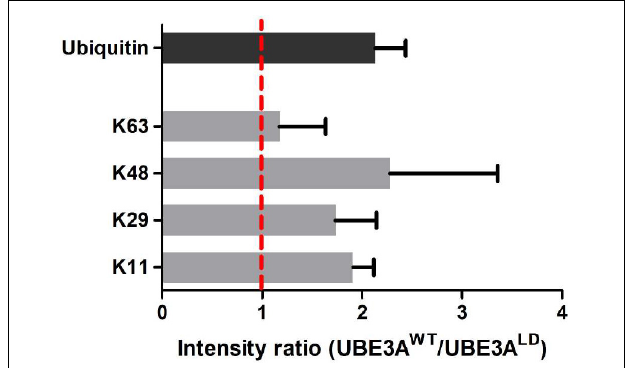
FIGURE 4 | Analysis of the ubiquitin linkages formed in DDI1. Four ubiquitination sites on ubiquitin were confidently identified and quantified by mass spectrometry. The intensity ratios for each ubiquitin chain type are given as the ratio of the UBE3A WT overexpressing condition over the intensity recorded for the UBE3A LD sample. The intensity ratio for ubiquitin is also indicated for reference. As K29 was not detected in neither of the UBE3A LD samples, its missing values were substituted by the lowest intensity value found in each